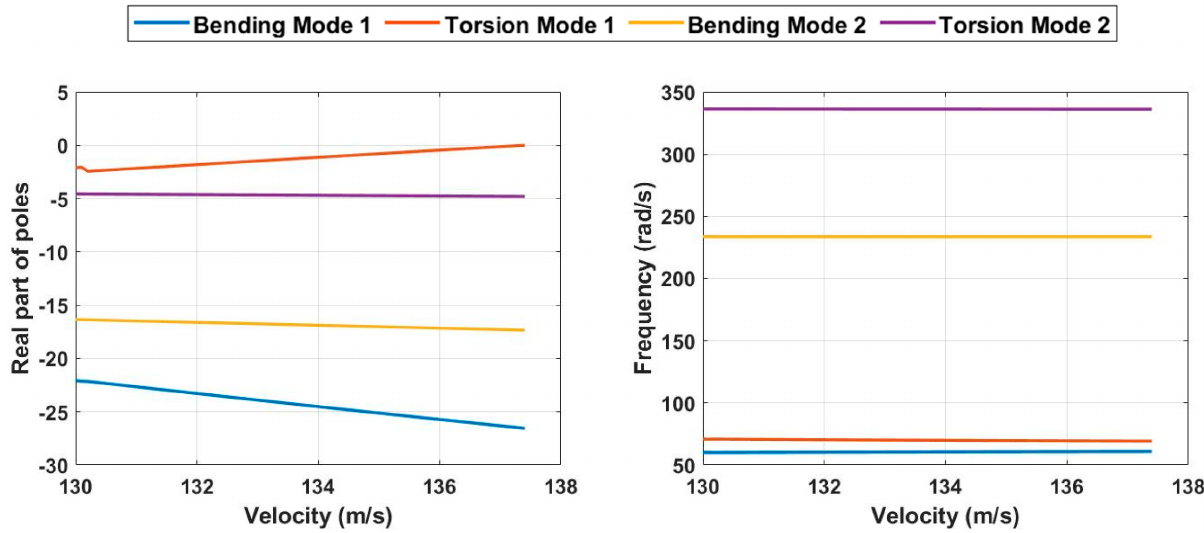
Figure 6. Convergence study performed for the finite element model with 1 element for adjoining torsional spring and an equal number of elements for inboard and outboard wing sections.